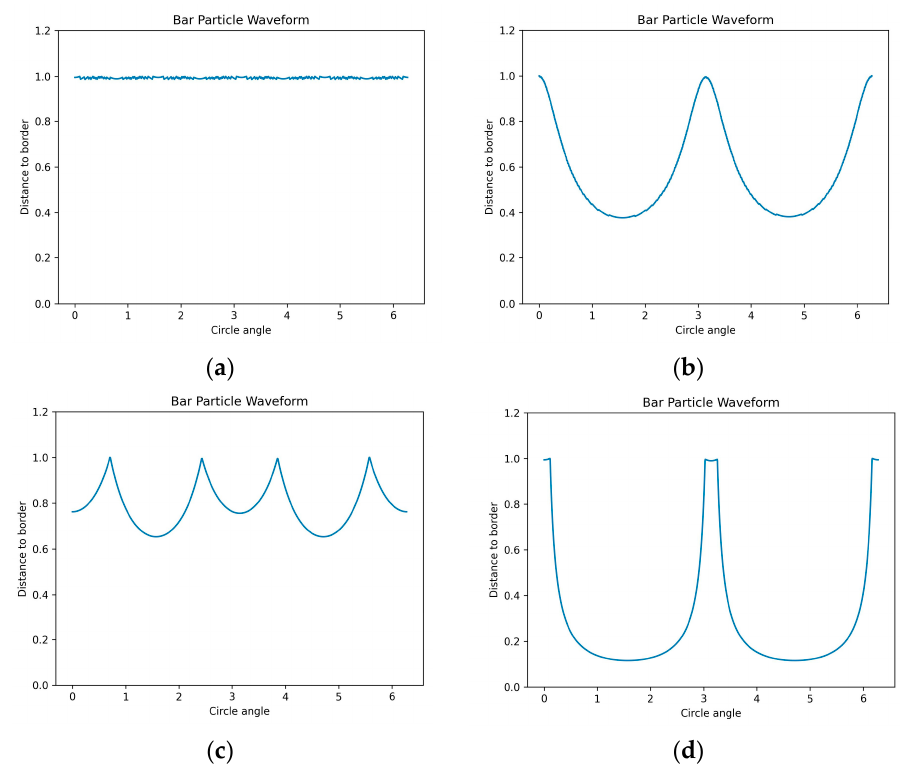
Figure 13. Oil-particle distance-angle waveform: ( a ) Spherical particles waveform; ( b ) Flattened spherical particles waveform; ( c ) Blocky particles waveform; ( d ) Strip particle